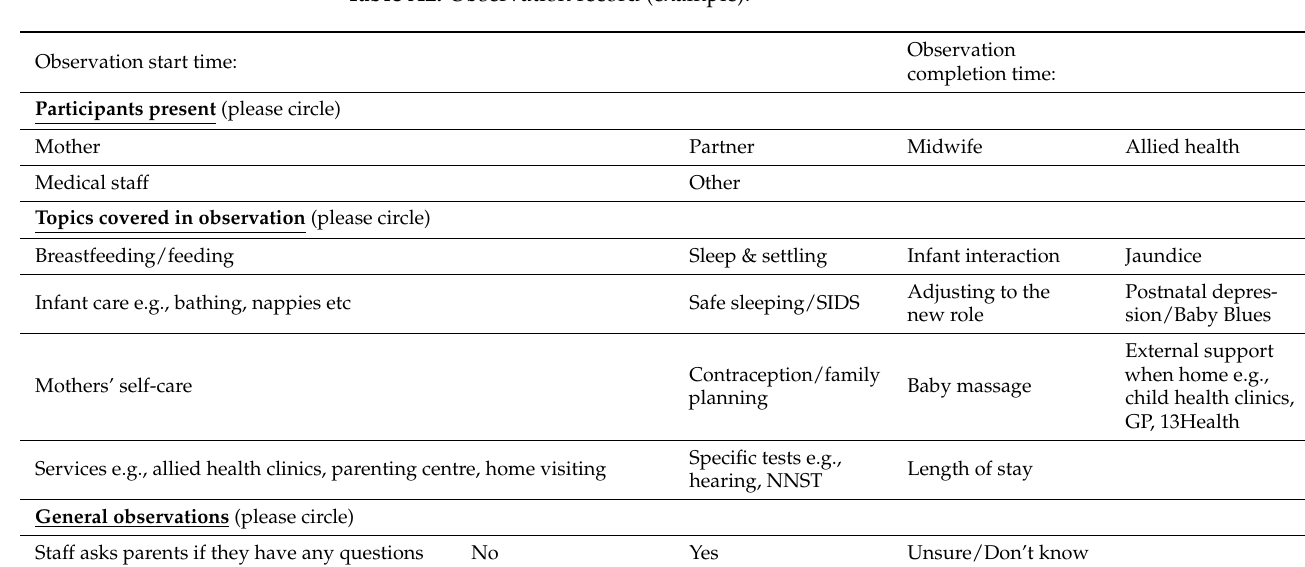
Table A2. Observation record